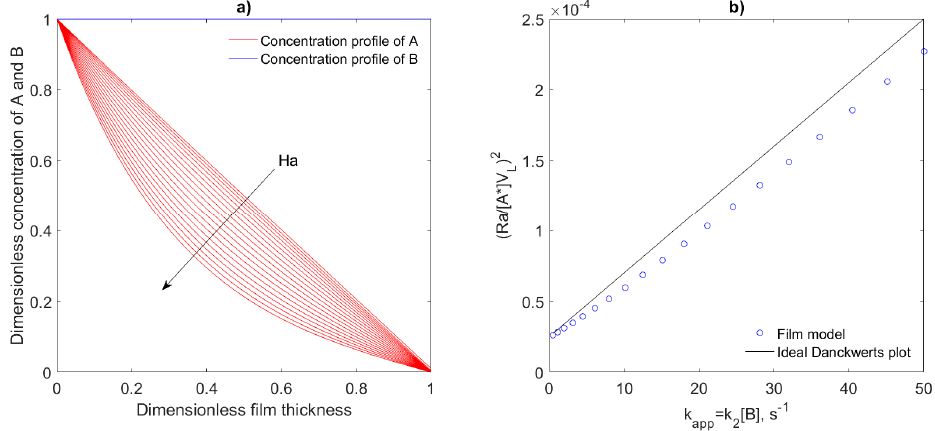
Figure 3. Concentration profiles ( a ) and Danckwerts’ plot ( b ) for ε l /( a GL · δ ) = 1.0 × 10 3 (bubble column).